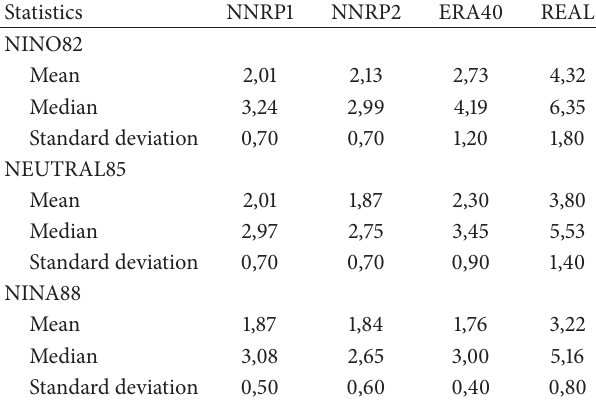
Table 2: Pearson product-moment correlation coefficient between three simulations and REAL data for annual